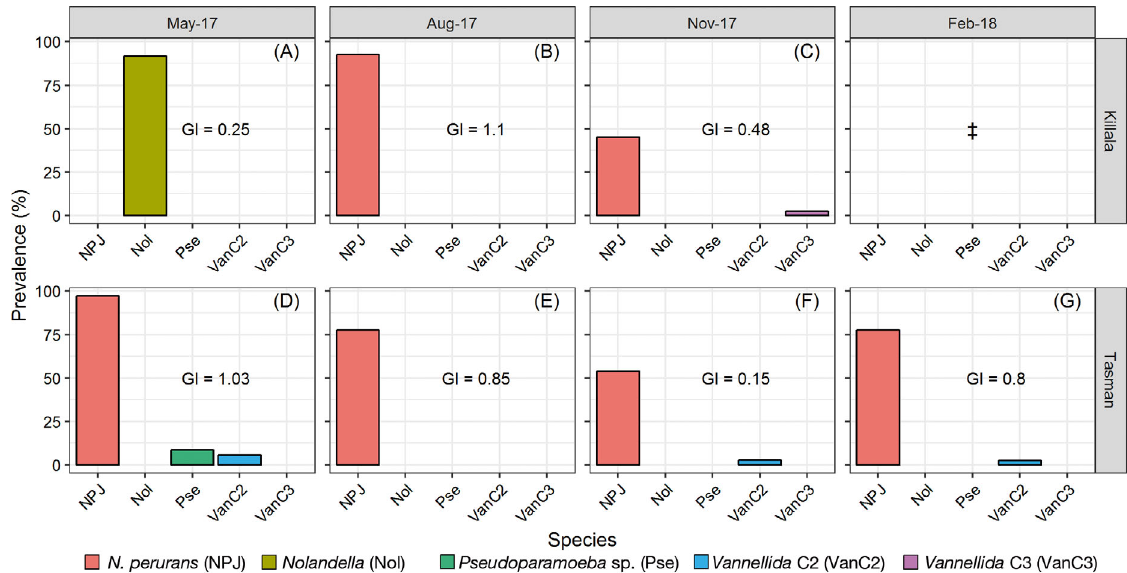
Fig. 2. (A−G) Prevalence of Atlantic salmon gills that were colonised by N. perurans (NPJ), Nolandella spp. (Nol), Pseudoparamoeba sp. (Pse) and Vannellida (VanC2, VanC3) at each farm site (Killala, Tasman) over a year. P. eilhardi was not included because no Atlantic salmon tested positive for the amoeba species. The average gill score (gill index [GI]) for each site and each time point is marked in the respective panels. The Feb 2018, Killala sampling event marked with ‡ is blank because